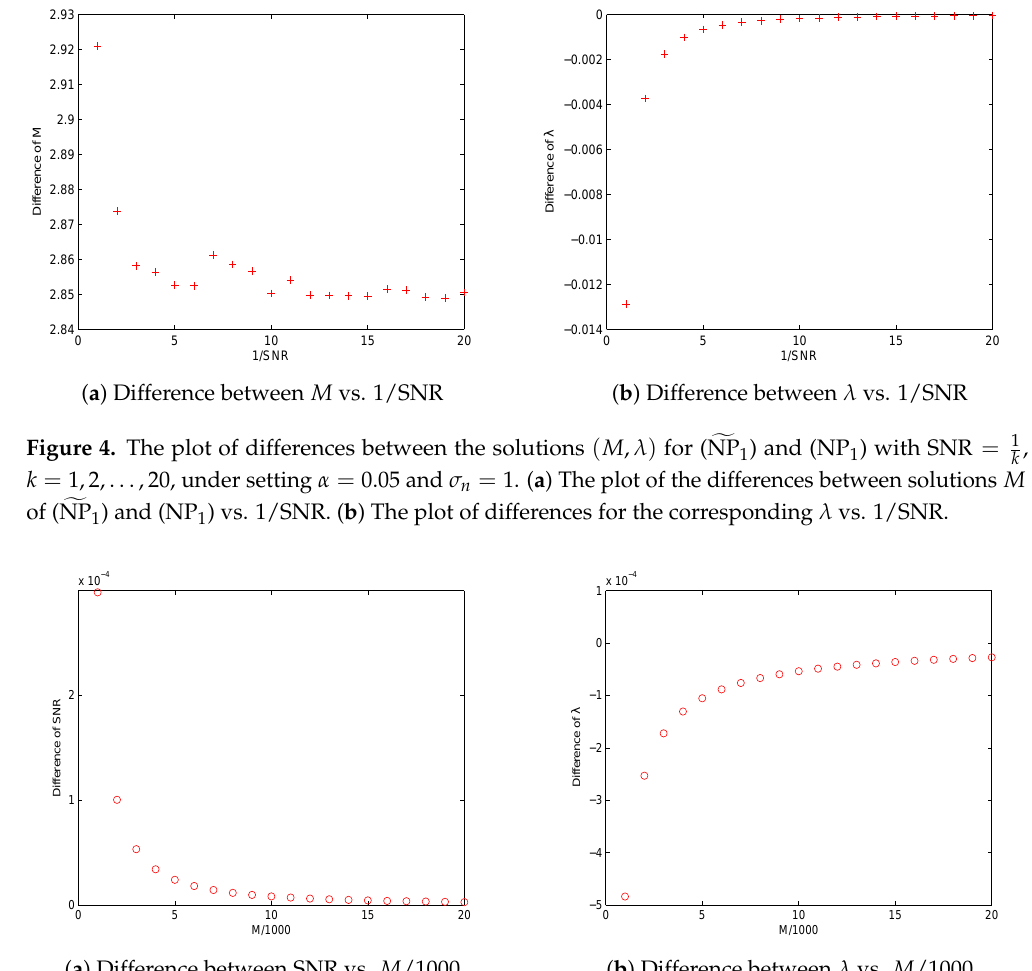
( a ) Difference between SNR vs. M /1000 ( b ) Difference between λ vs. M /1000 Figure 5. The plot of differences between the solutions ( SNR , λ ) for ( k = 1,2, . . . ,20, under setting α = 0.05 and σ n = 1. ( a ) The plot of the differences between solutions SNR of ( NP 2 ) and (NP 2 ) vs. M /1000. ( b ) The plot of differences for the corresponding λ vs. M (cid:102)